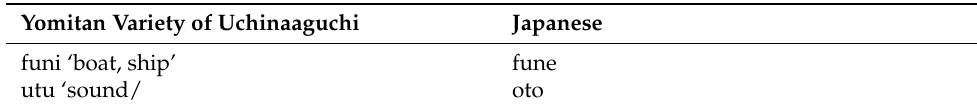
Table 3. Example words showing phonological correspondences.